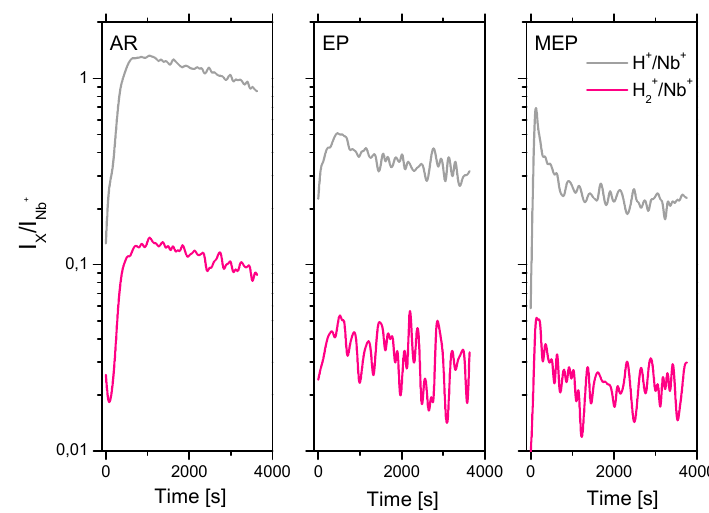
Figure 12. Change in the ratio of hydrogen positive secondary ions (H + and H 2+ ) currents to the niobium secondary ions currents vs. the ion etching time. Etching time 3600 s corresponds with depth of the niobium etched layer equaling to about 70 nm.